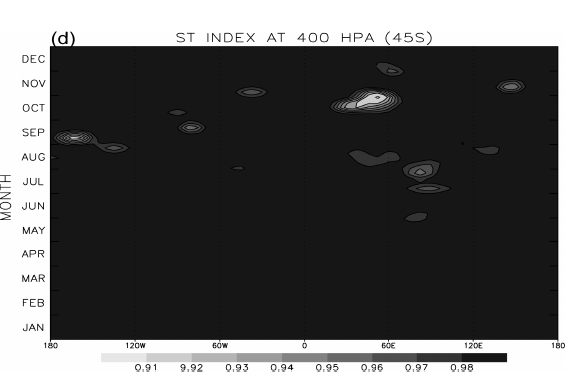
Fig. 3. The same as in Fig. 2 but for latitude at 45 ◦